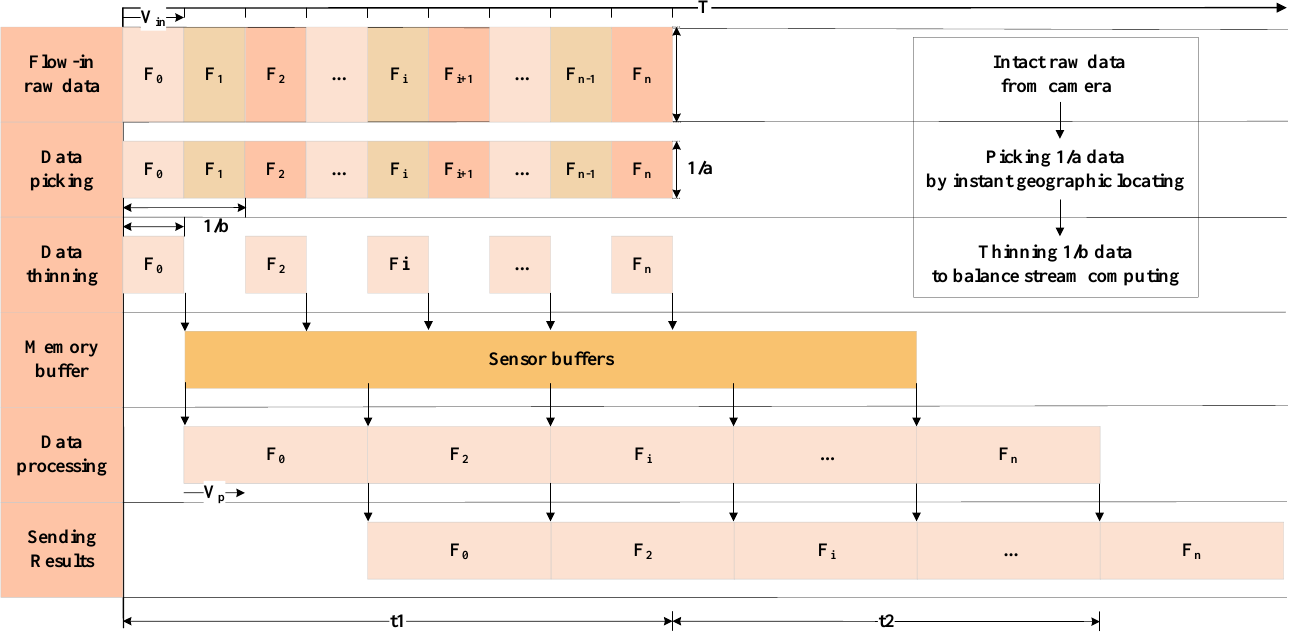
Figure 6. Processing timeline of the application.